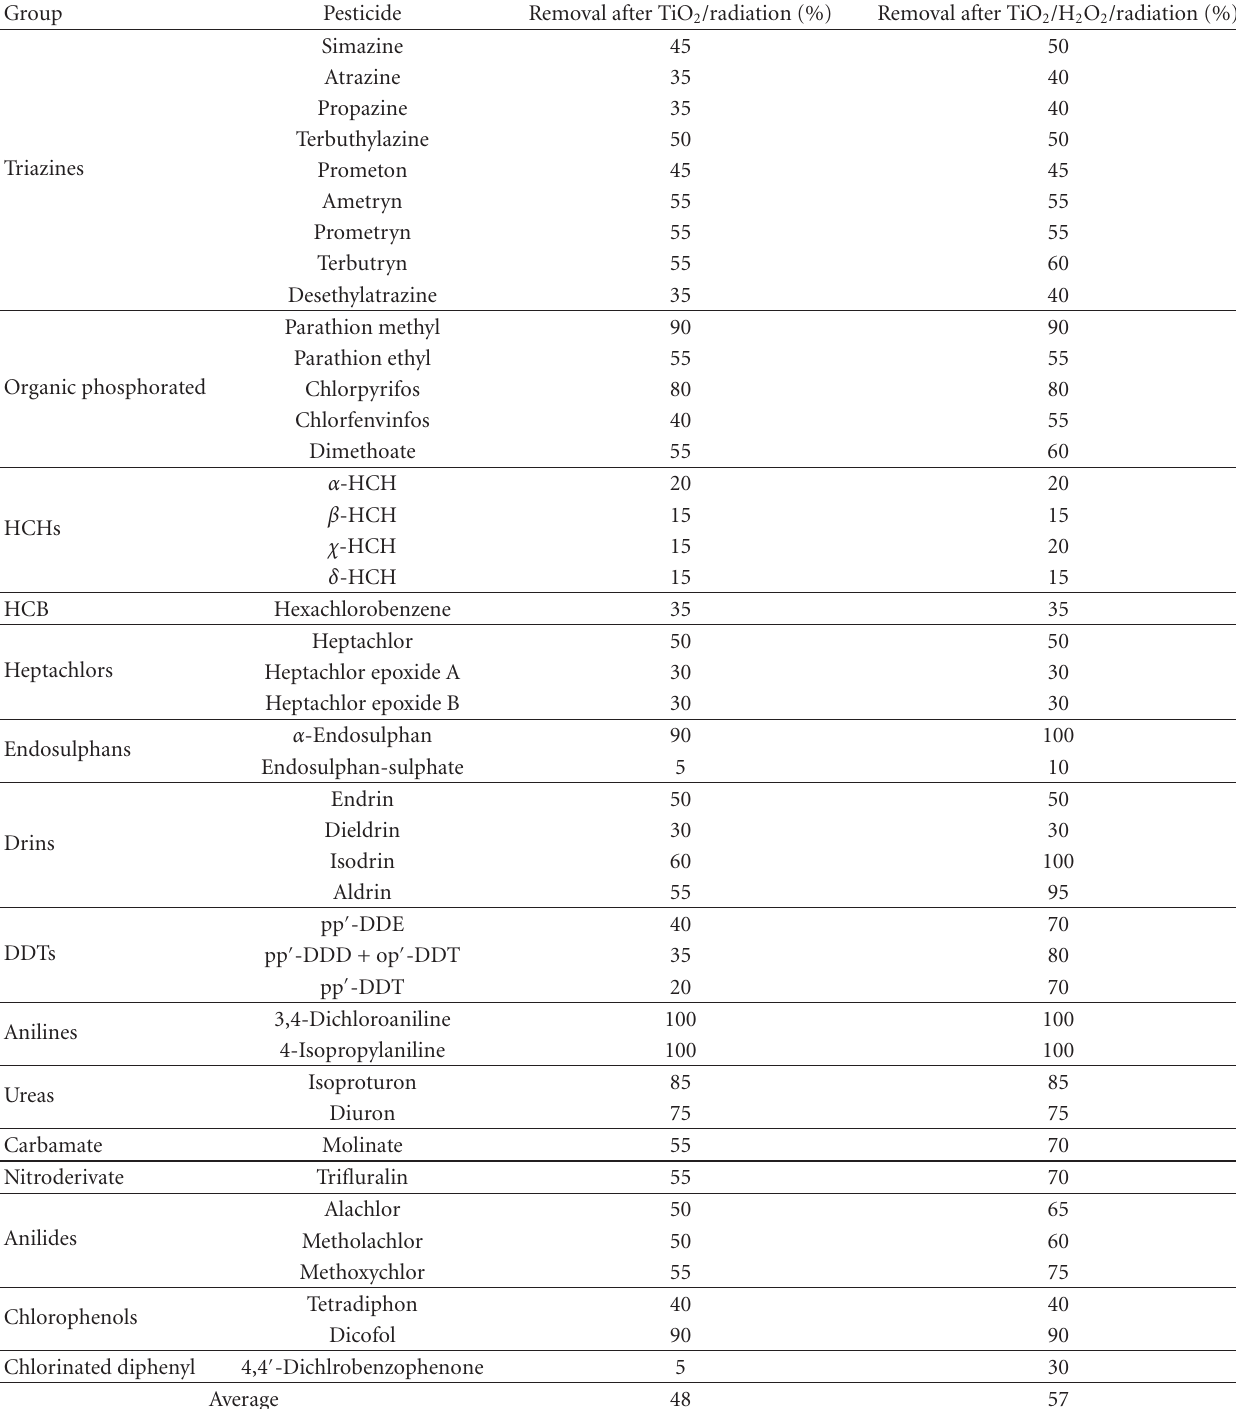
Table 7: % Removal of pesticides by photocatalytic